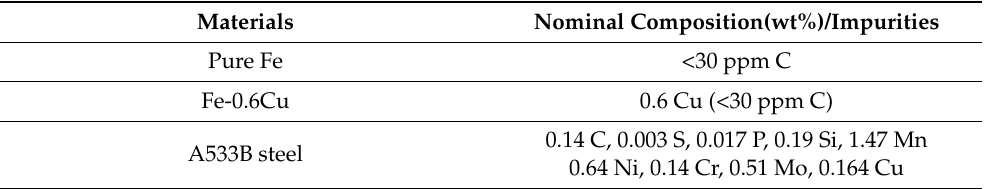
Table 1. Chemical composition of the materials used in the study (wt%).